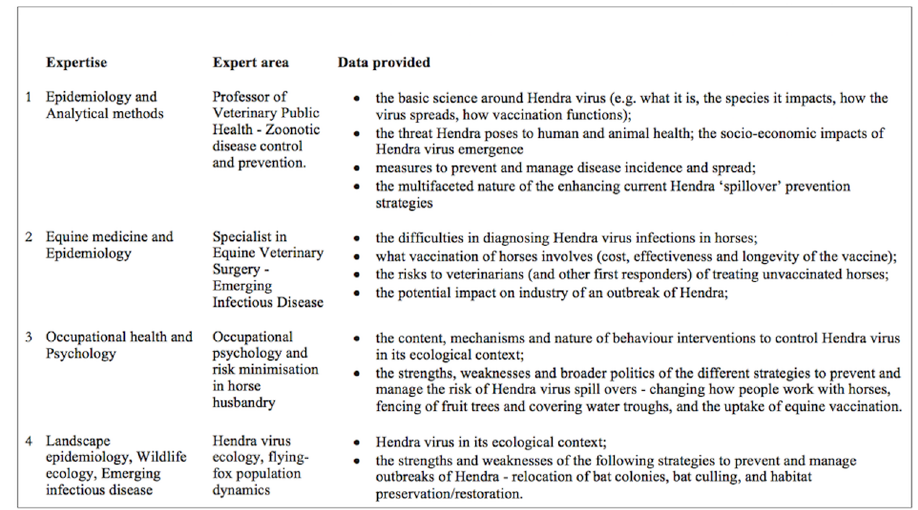
Fig 3. Expert testimony provided to the community